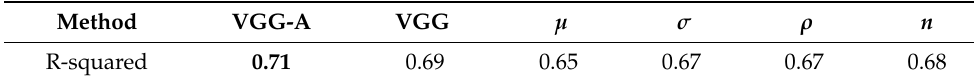
Table 3. Results of ablation